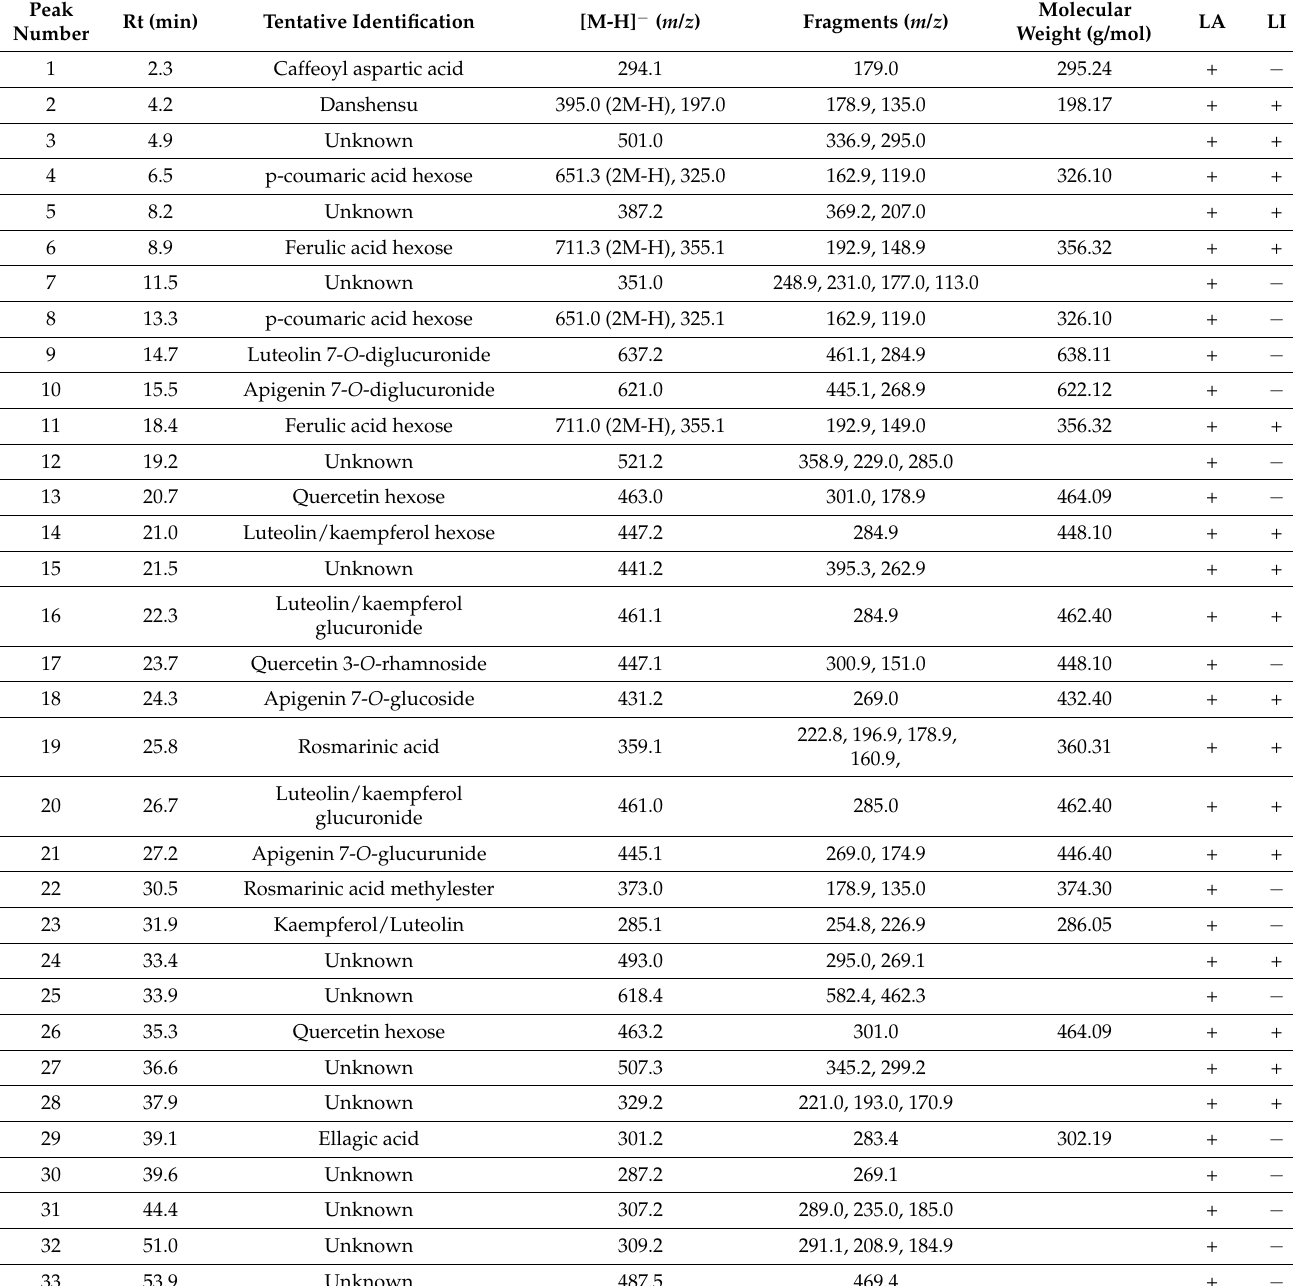
Table 2. LC-ESI-MS and MS/MS data (negative ionization mode) of the tentatively identified compounds in L. angustifolia (LA) and L. intermedia extracts. The symbols “+” and “ − ” indicate the presence or the absence of the compounds in the